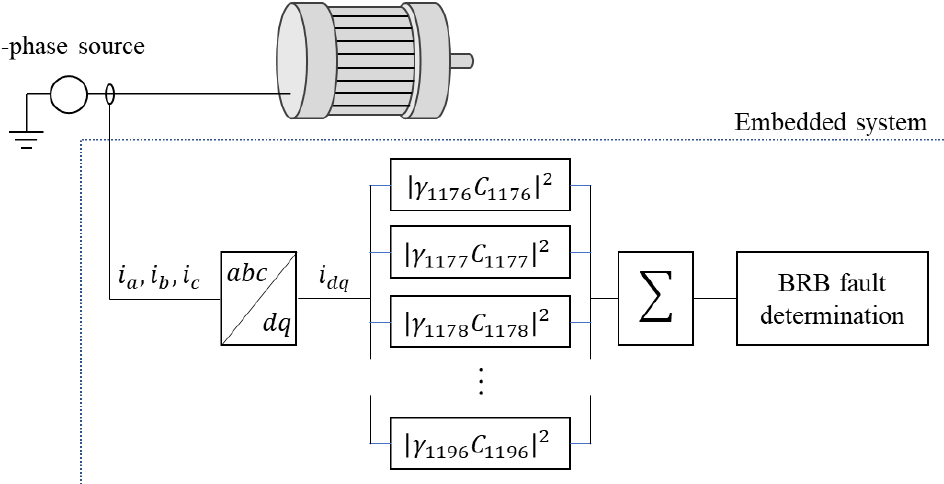
Figure 10. Block diagram of the proposed BRB fault diagnosis method.